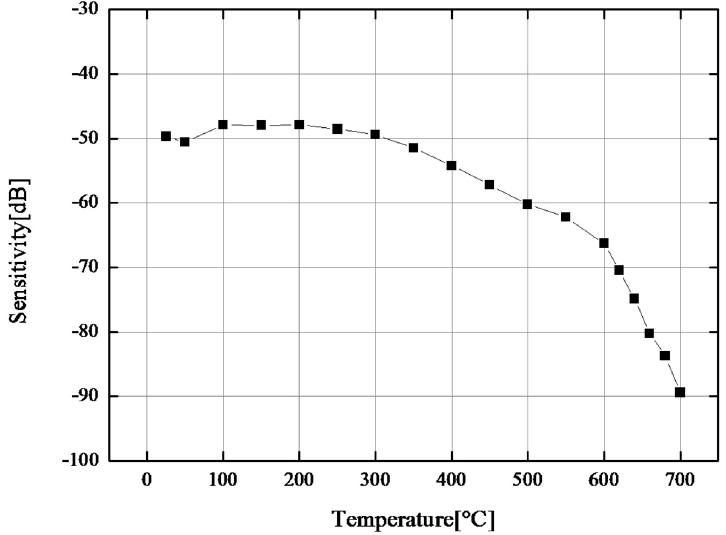
Figure 4. Sensitivity of CBT/PZT films fabricated on 3-mm-thick 900 mm 2 titanium substrate at various temperatures.